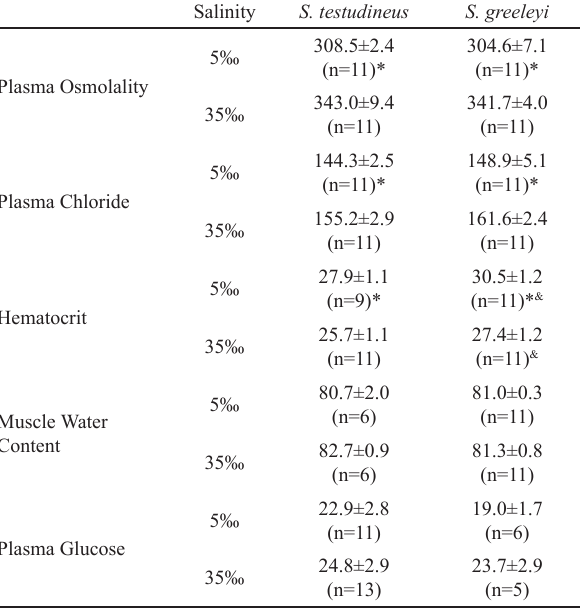
Table 1. Plasma osmolality (mOsm.kgH O -1 ), chloride (mM), 2 plasma glucose (mg.dL -1 ), hematocrit (%), and muscle water content (%) of Sphoeroides testudineus and S. greeleyi after short-term exposure to seawater of 5‰ or 35‰ salinity, mean ± standard error. * = salinity effect (5‰ ≠ 35‰), p<0.05; & = species effect ( S. testudineus ≠ S. greeleyi ),